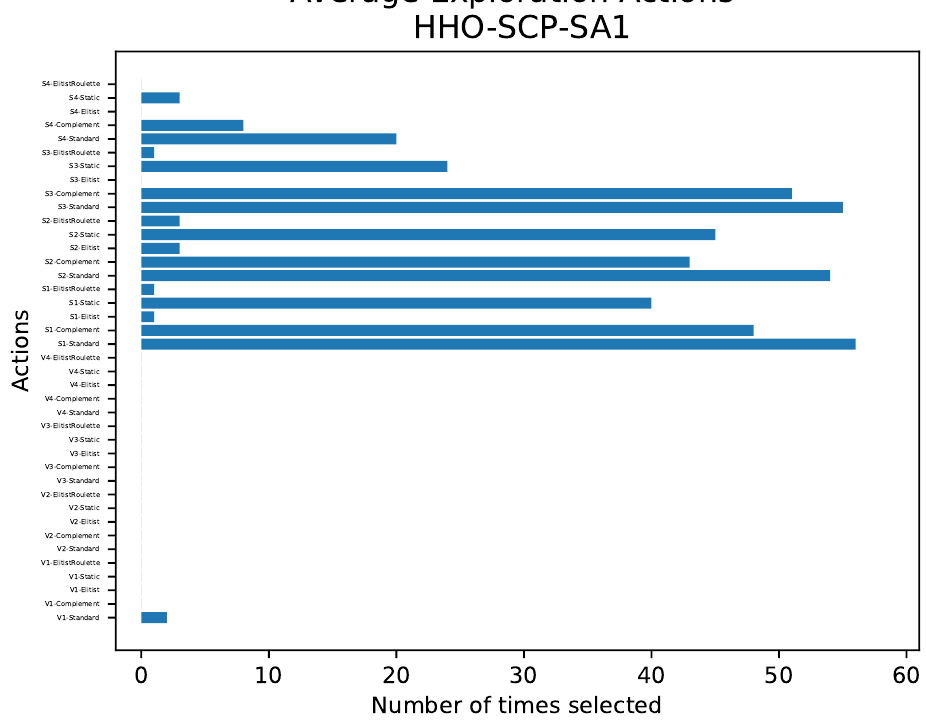
Figure 13. HHO-SA1 —The average number of actions in the exploration